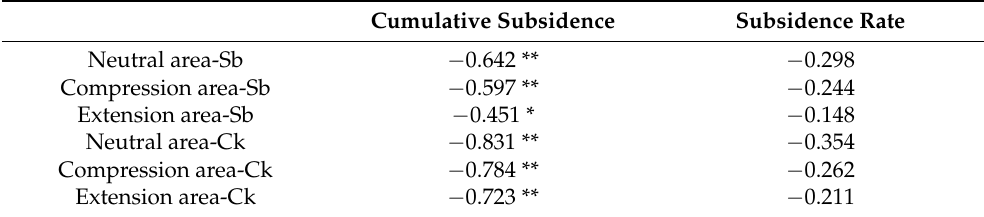
Table 3. The Pearson correlation coefficient between the degradation coefficient and subsidence parameters at leaf scale.